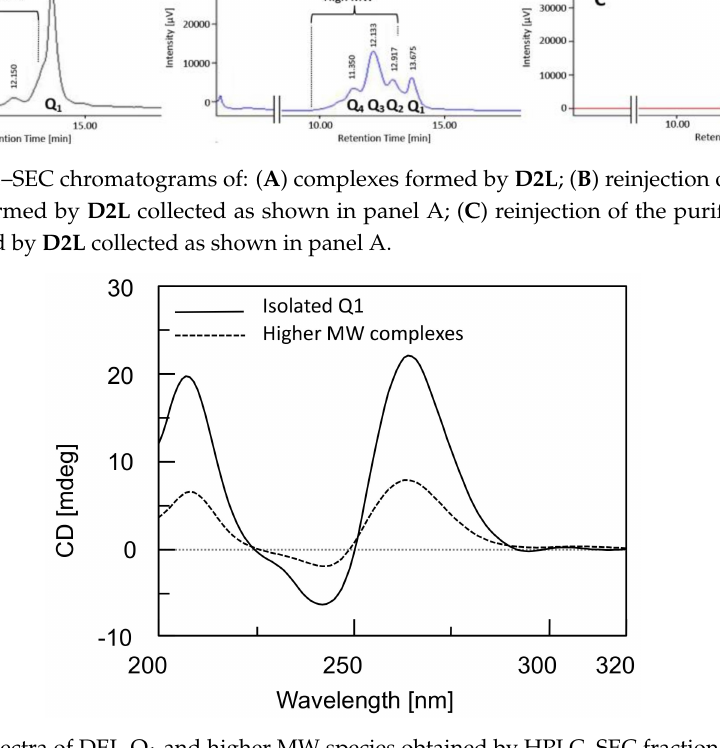
Figure 7. CD spectra of DEL-Q 1 and higher MW species obtained by HPLC–SEC fractionation of D2L (100 mM K + -containing buffer, 5 ◦